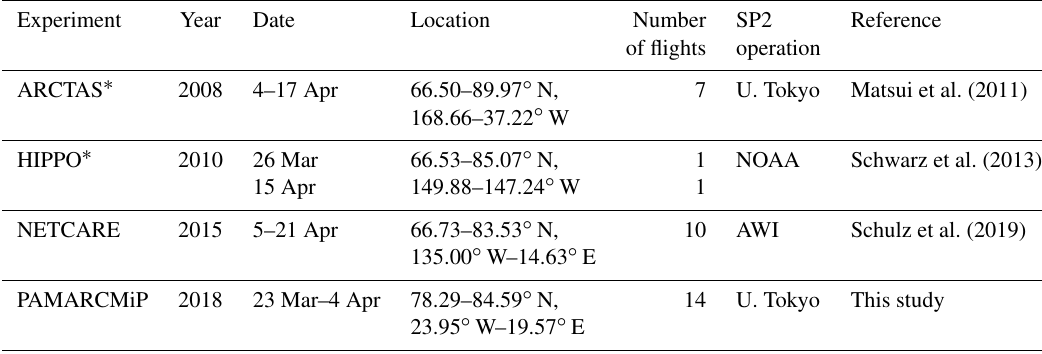
Table 3. Aircraft experiments made during the Arctic